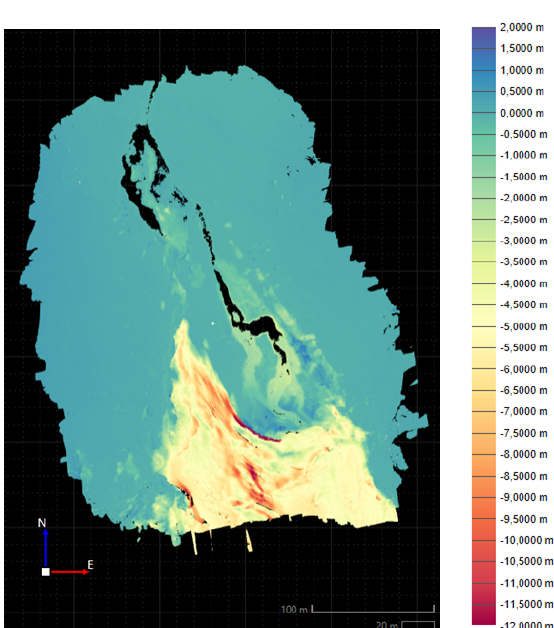
Figure 9. Height comparison map between the 2020 and 2021 DPCs - standard photogrammetric pipeline.